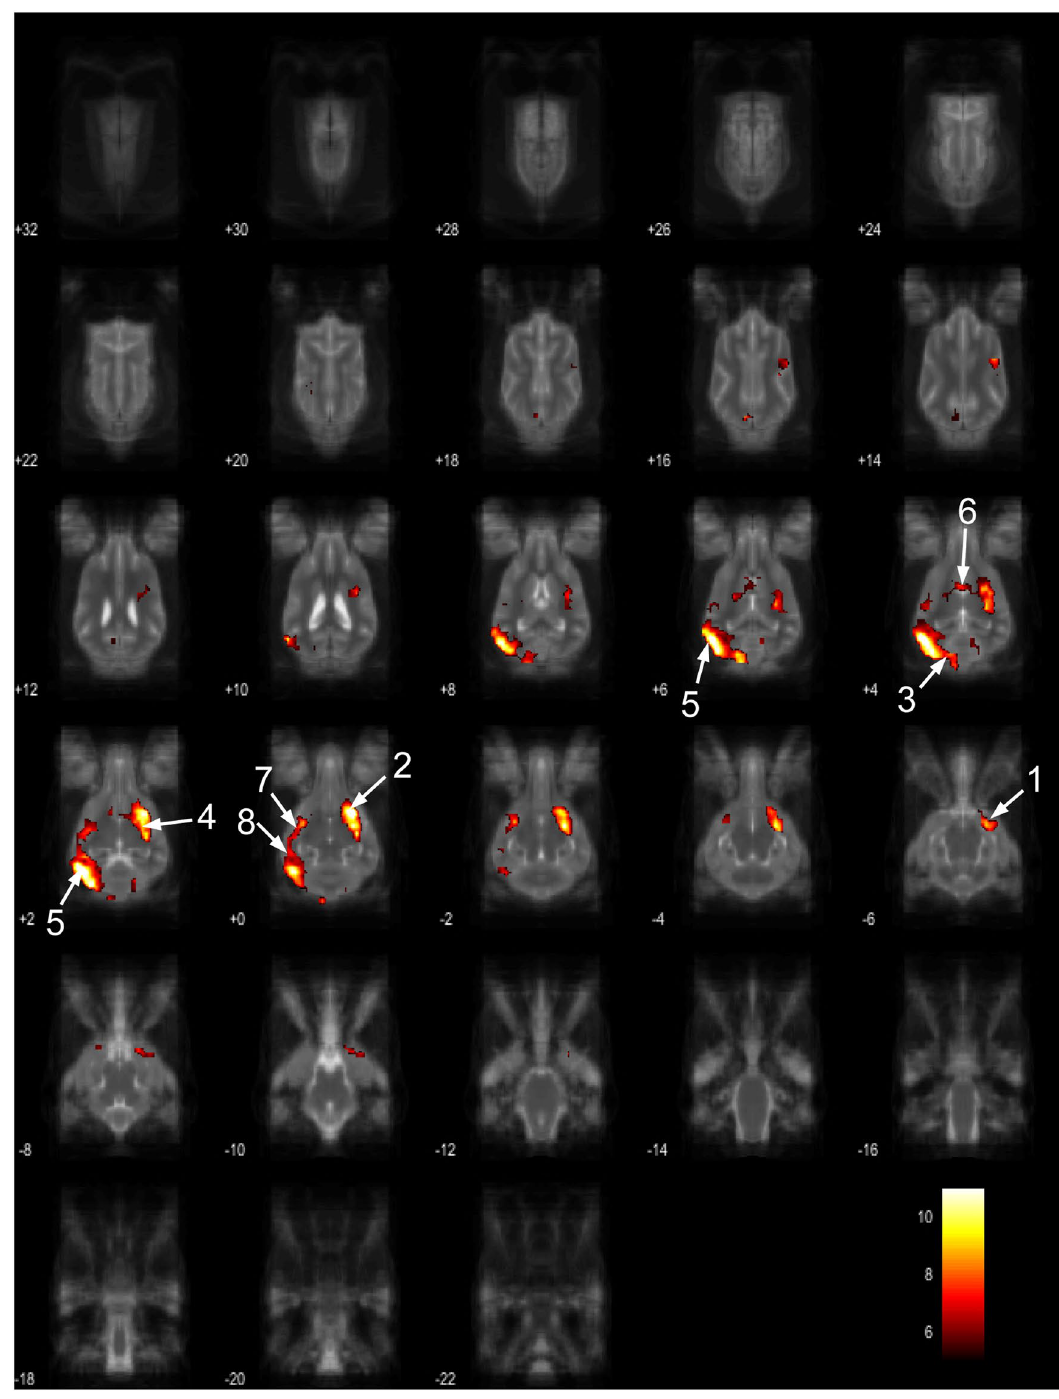
Figure 8. Resting-state network component E from the 15 component gICA. We report the results with a voxel- wise FDR corrected p < 0.001 and cluster treshold of FDR corrected p < 0.005. gICA components are presented as thresholded T-maps, corrected for multiple comparisons, overlaid on the Nitzsche atlas 15 . 1. right amygdala, 2. Striatum, 3. Cerebellum, 4. right insular cortex, 5. left visual cortex, 6. septal nuclei, 7. left sylvian gyrus, 8. left ectosylvian